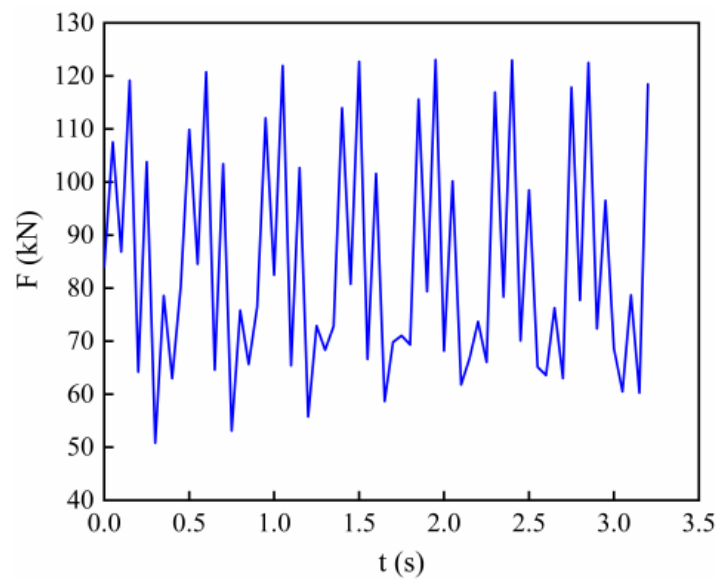
Figure 4. Vibration load time curve of train.